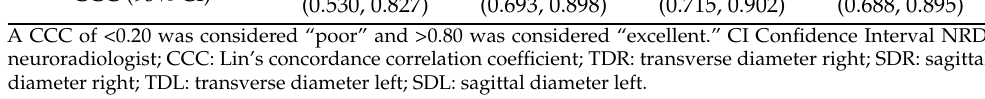
Table 3. Intra-rater agreement in ONSD MRI assessment for NRD 2. NRD 2— Assessment t1 vs. t2